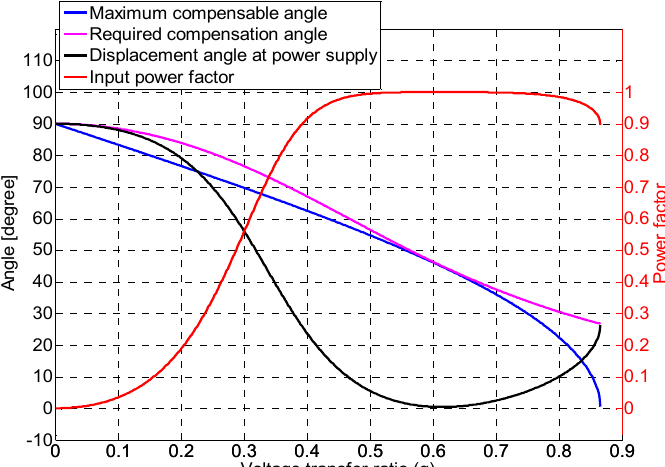
Figure 9. Maximum allowable compensated angle, required compensation angle, displacement angle, and IPF at the main power supple at 0.375 Q = .